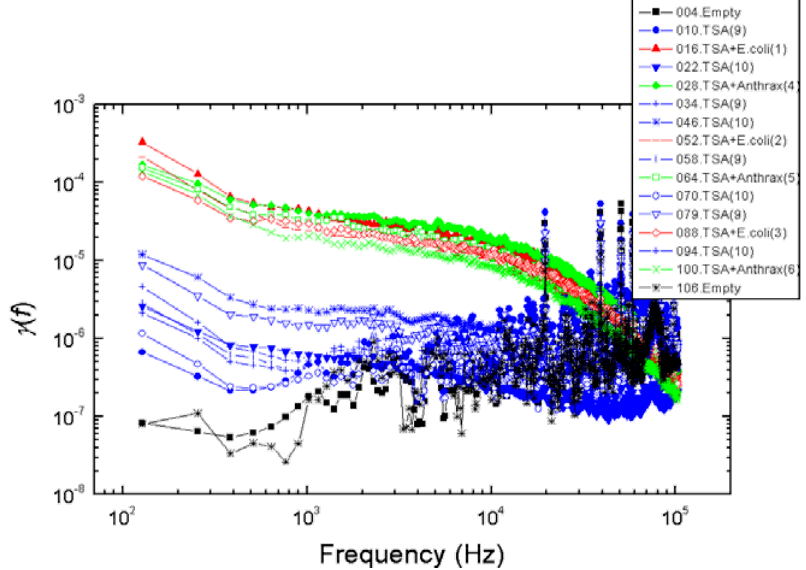
Figure 6. Reproducibility of the experimental data shown in Figures 5 with new